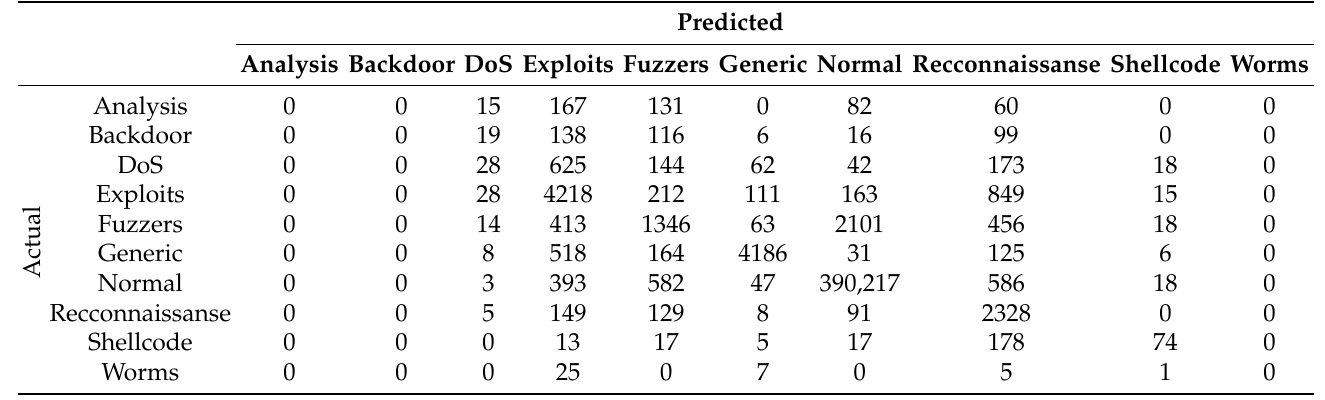
Table 18. Confusion matrix for UNSW-NB15 “reduced features” multiclass classification experiment. Predicted